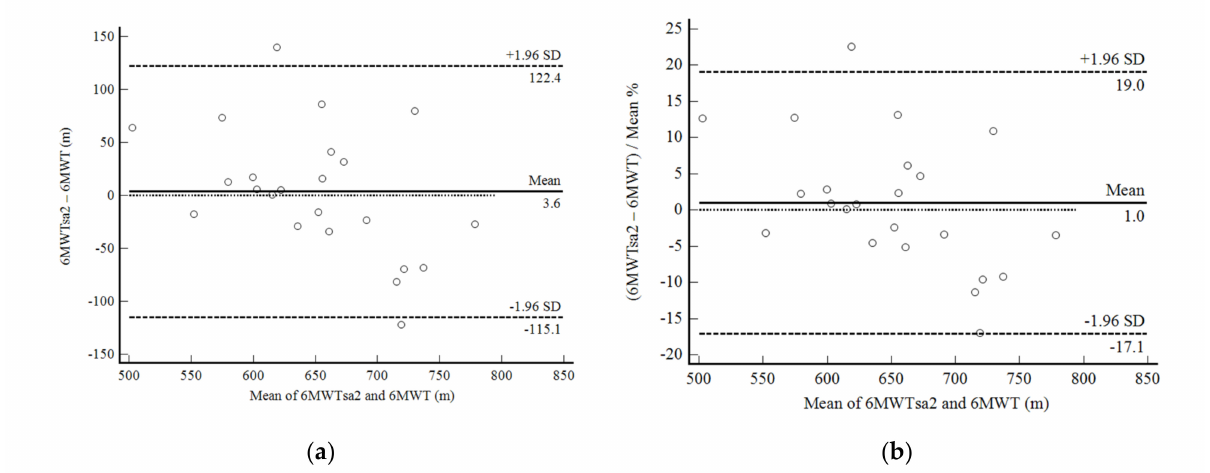
Figure 5. Bland and Altman graphic method with limits of agreement and 95% confidence interval (95%CI) between the distance walked estimated by the number of steps and demographic and anthropometric attributes in the second self-administered six-minute walk test (6MWTsa2) and the supervised six-minute walk test distance (6MWT). ( a ) absolute values; ( b ) percentage